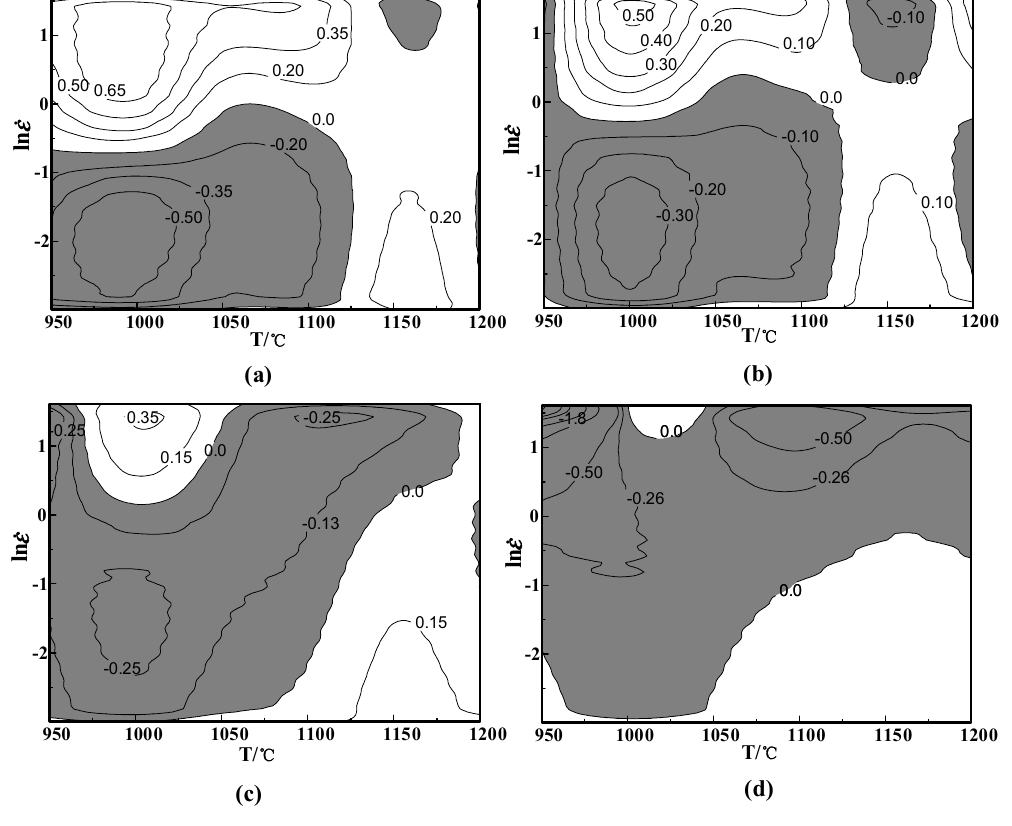
Figure 8. Instability maps at different strains: ( a ) ε = 0.2; ( b ) ε = 0.3; ( c ) ε = 0.4; ( d ) ε = 0.5.